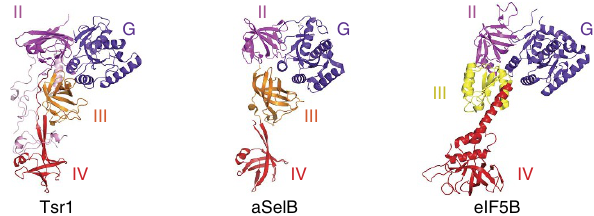
Figure 3 | Tsr1 is related to translational GTPases. Tsr1, aSelB (PDBid 9ac4) and eIF5B from budding yeast (PDBid 3wbk) are shown in a similar orientation after structural alignment. Equivalent domains are coloured according to the schema in Fig. 1. Domain III of eIF5B (yellow) has a different topology to domain III in Tsr1 and